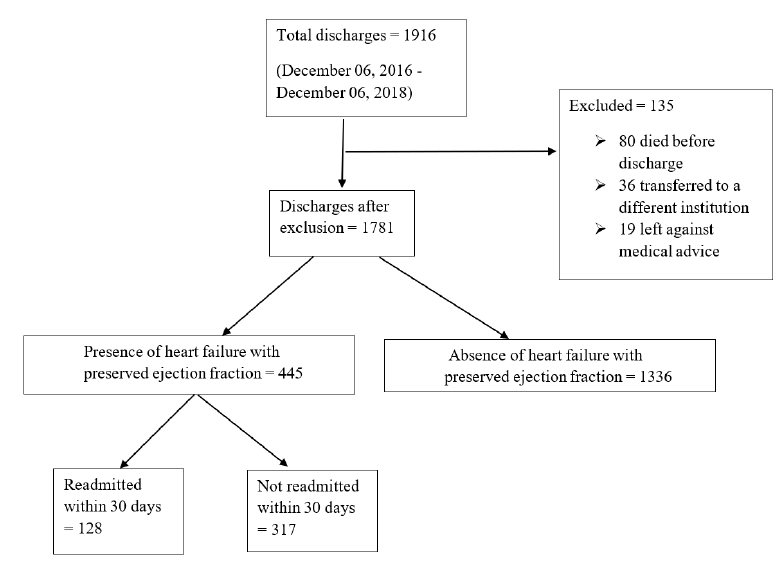
Figure 1. A diagrammatic representation of the flow of the study and distribution of total study size. Table 1. Hospital admission characteristics of study